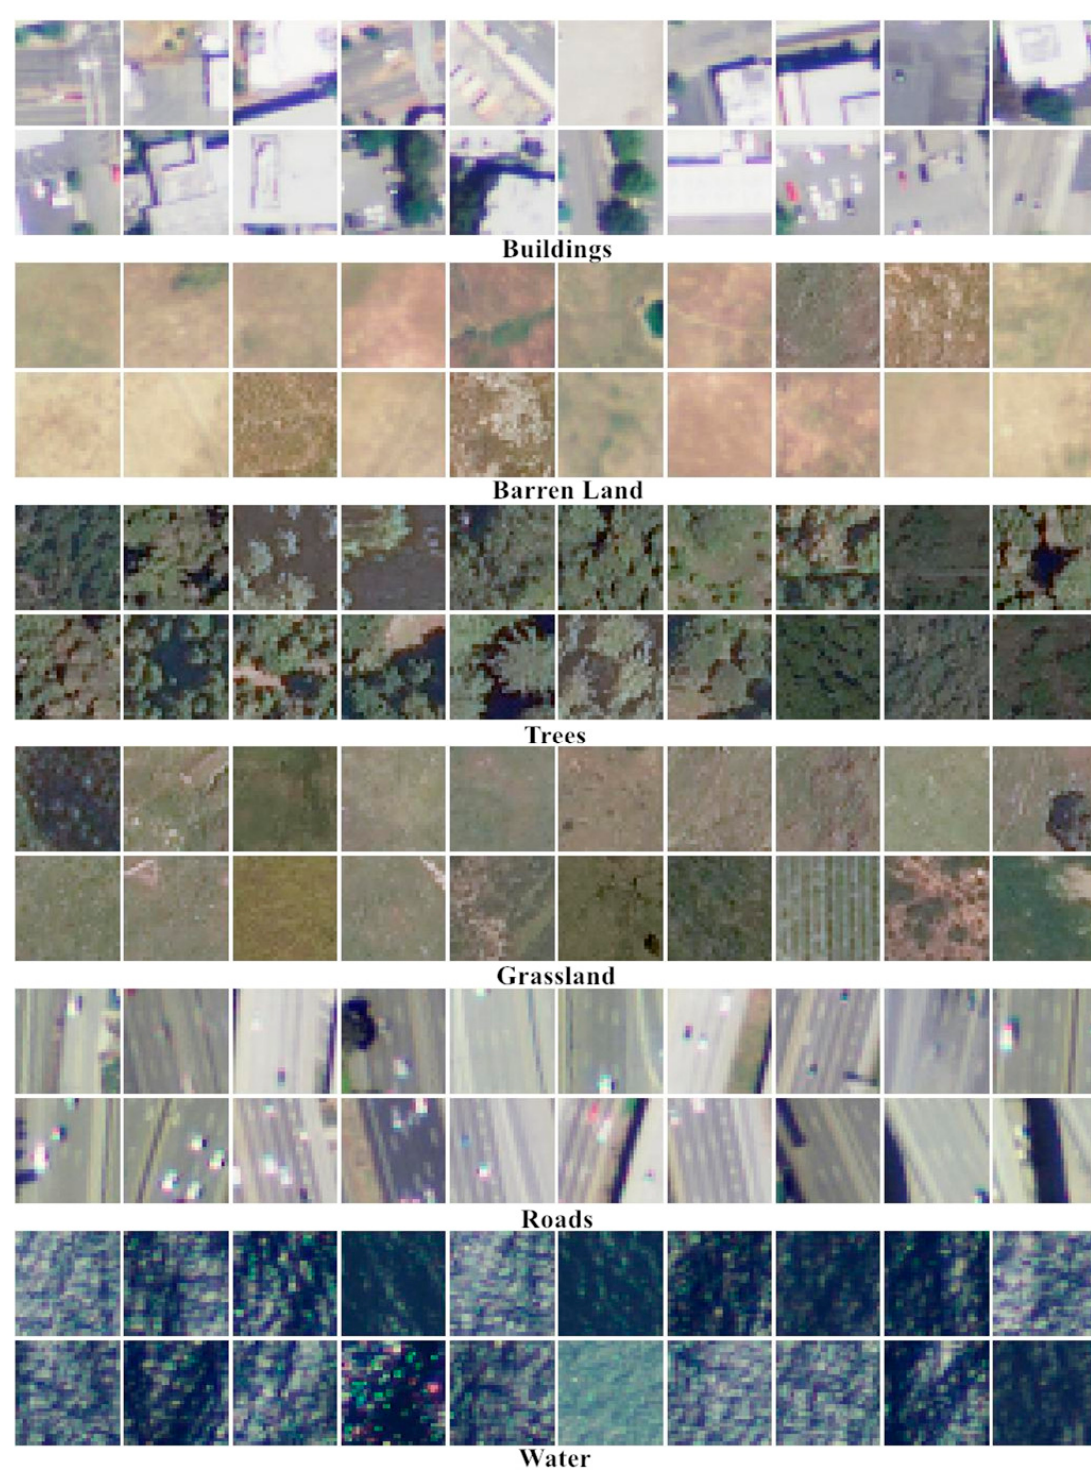
Figure 4. Visual samples of the SAT-6 dataset.